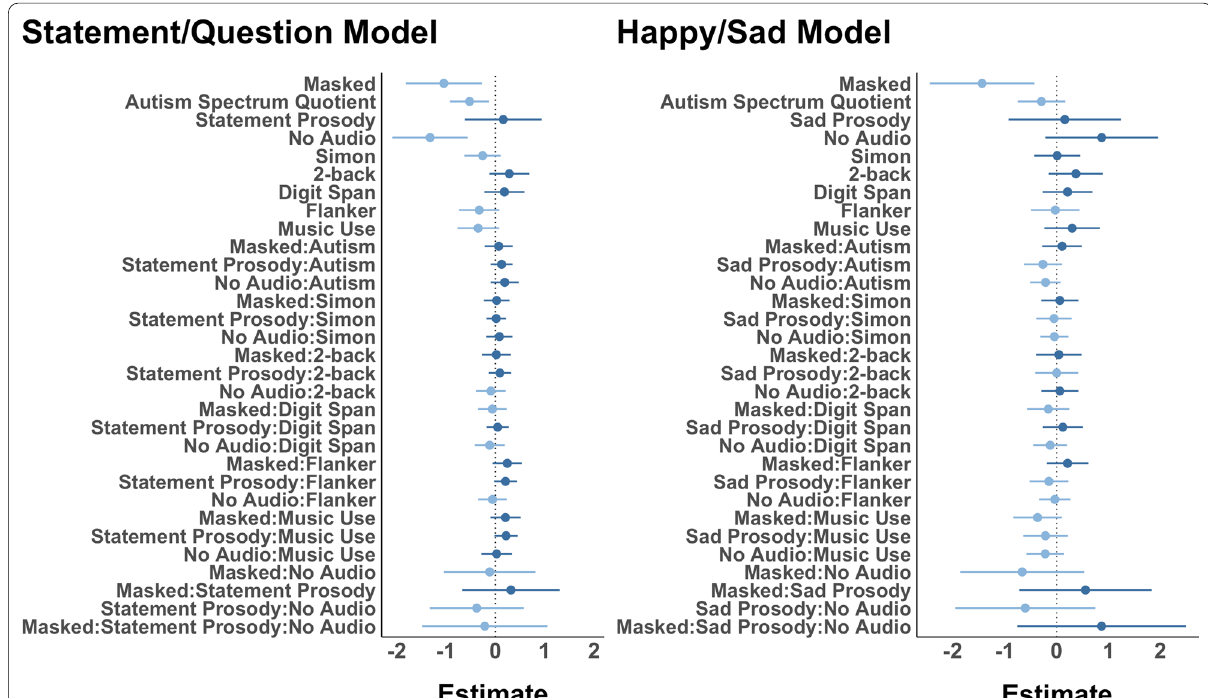
Fig. 4 Mixed-effects logistic regression estimates for statement/question prosody model (left) and happy/sad prosody model (right). The plot shows the log-odds estimate along with 95% confidence intervals. Darker shade indicates a positive estimate; lighter shade indicates a negative